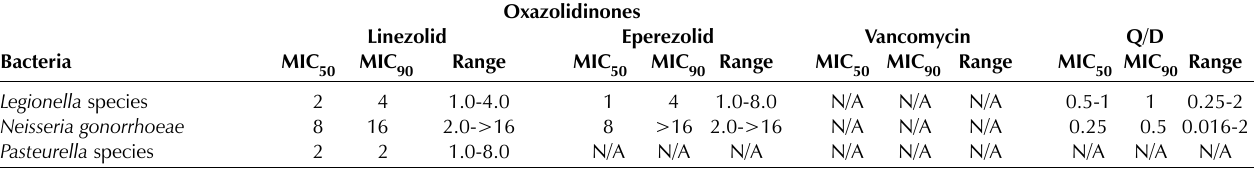
In vitro activity of oxazolidinones, vancomycin and quinupristin/dalfopristin (Q/D) against miscellaneous bacteria Oxazolidinones